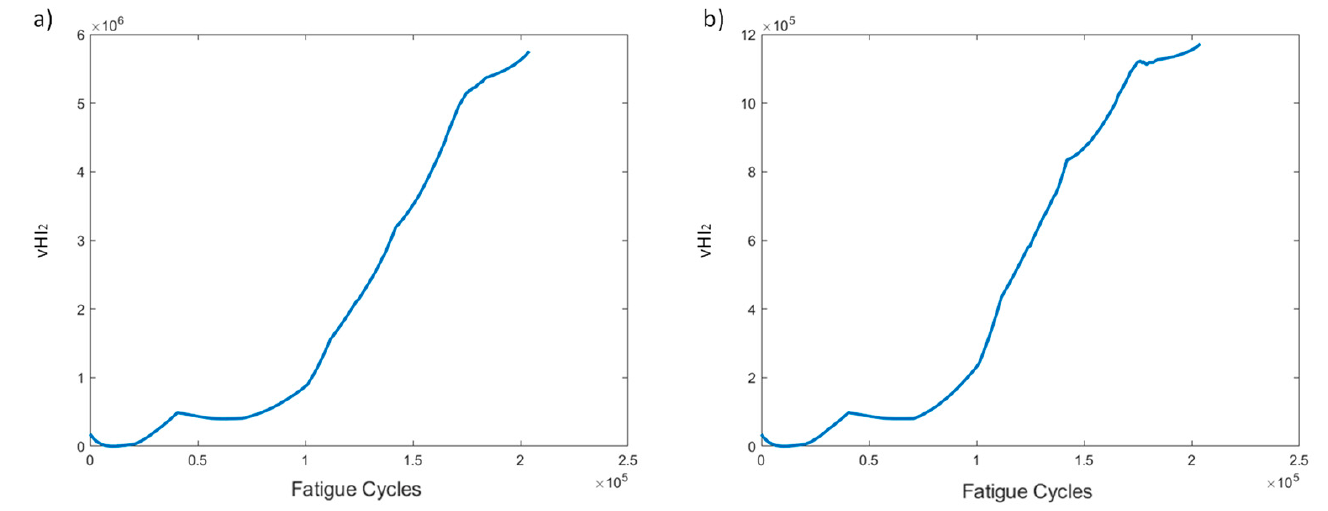
Figure 19. vHI 2 progression through time for the two pre-processing methods for specimen VA-1: ( a ) method 1, ( b ) method 2.